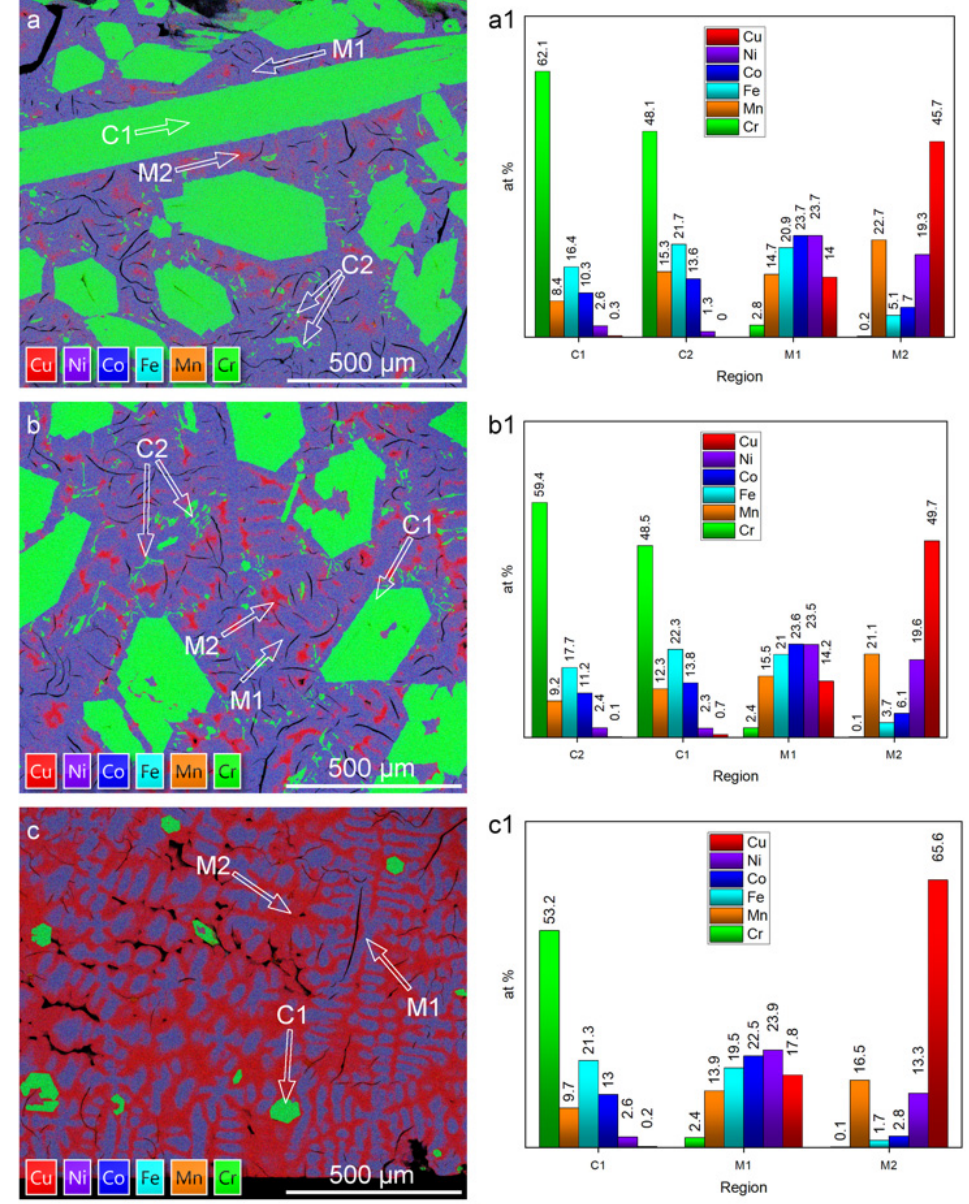
Figure 9. Layered EDS maps taken from regions of interest from the ( a ) top, ( b ) middle, and ( c ) bottom of the ingot. Bar charts quantifying the composition of microstructural features C1, C2, M1, and M2 are shown for regions of interest at the ( a1 ) top, ( b1 ) middle, and ( c1 ) bottom of the sample. Overall, four (C1, C2, M1 and M2) compositionally and morphologically distinct features can be identified and are representative of the microstructure of the cast